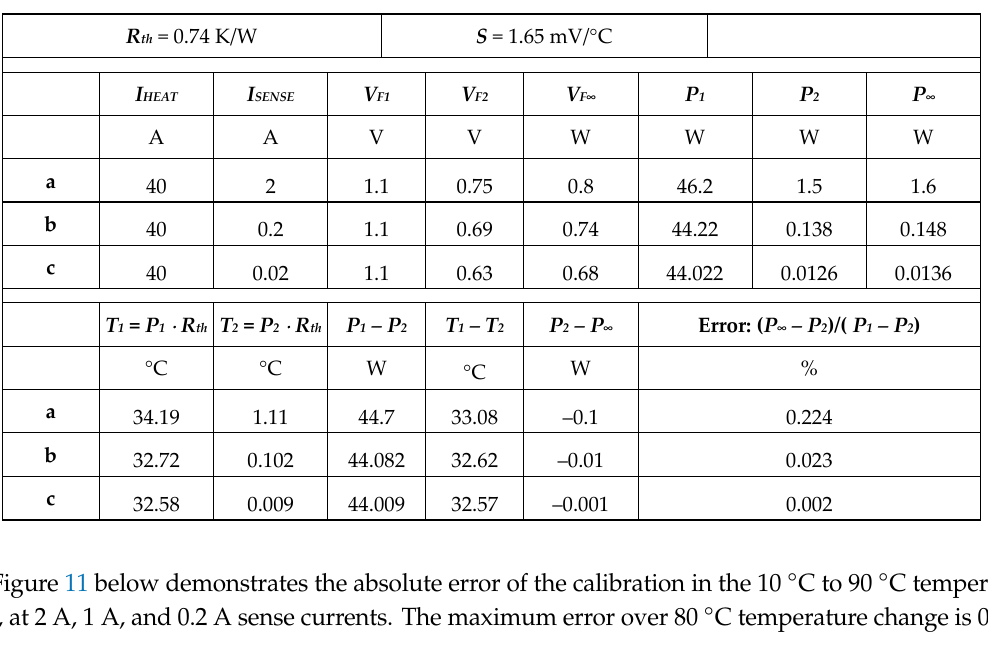
Table 2. Calculated voltage, temperature, and power on the solid state relay device at several heating and sensing currents.